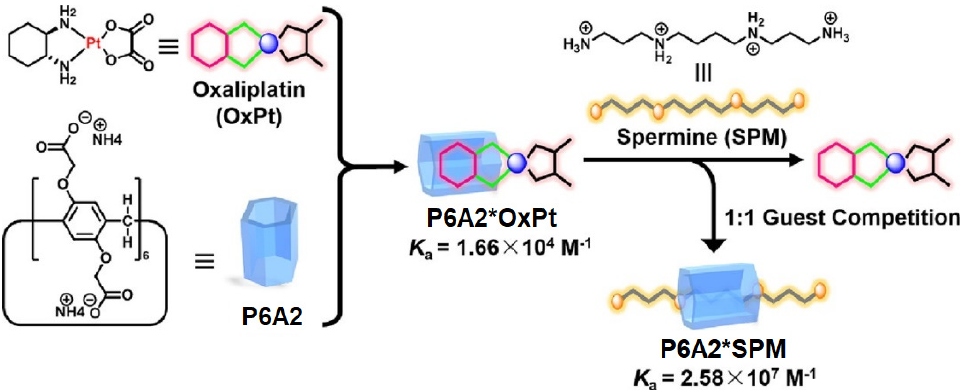
Figure 16. Schematic representation of the spermine-responsive P6A2 -based OxPt delivery system. Reproduced with the permission of reference [95]. Copyright © American Chemical Society 2018.